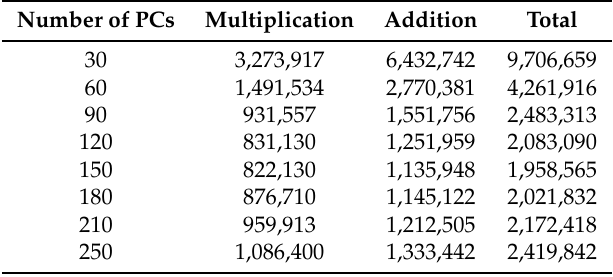
Table 2. Computational complexity of PCT + PDS method according to number of PCs.